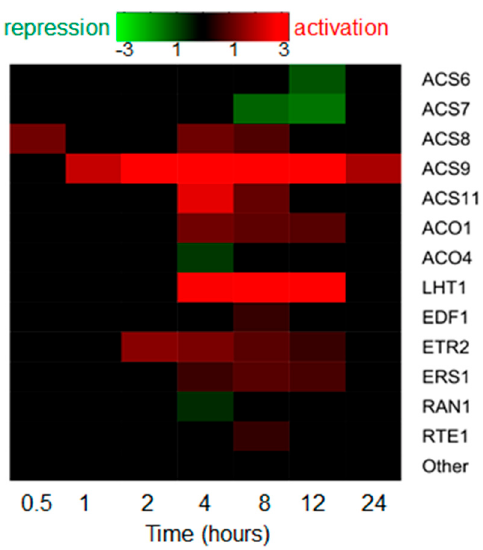
Figure 2. Transcriptional regulation of ethylene-related genes by IAA in the Arabidopsis root. The datasets from Lewis et al. [19] were analyzed. Only the genes with significant expression changes (Benjamini-Hochberg FDR < 0.05) are shown in the heatmap. “Other” are the rest of genes from ACS, ACO families and the genes involved in ethylene signaling and overviewed in chapter 1.